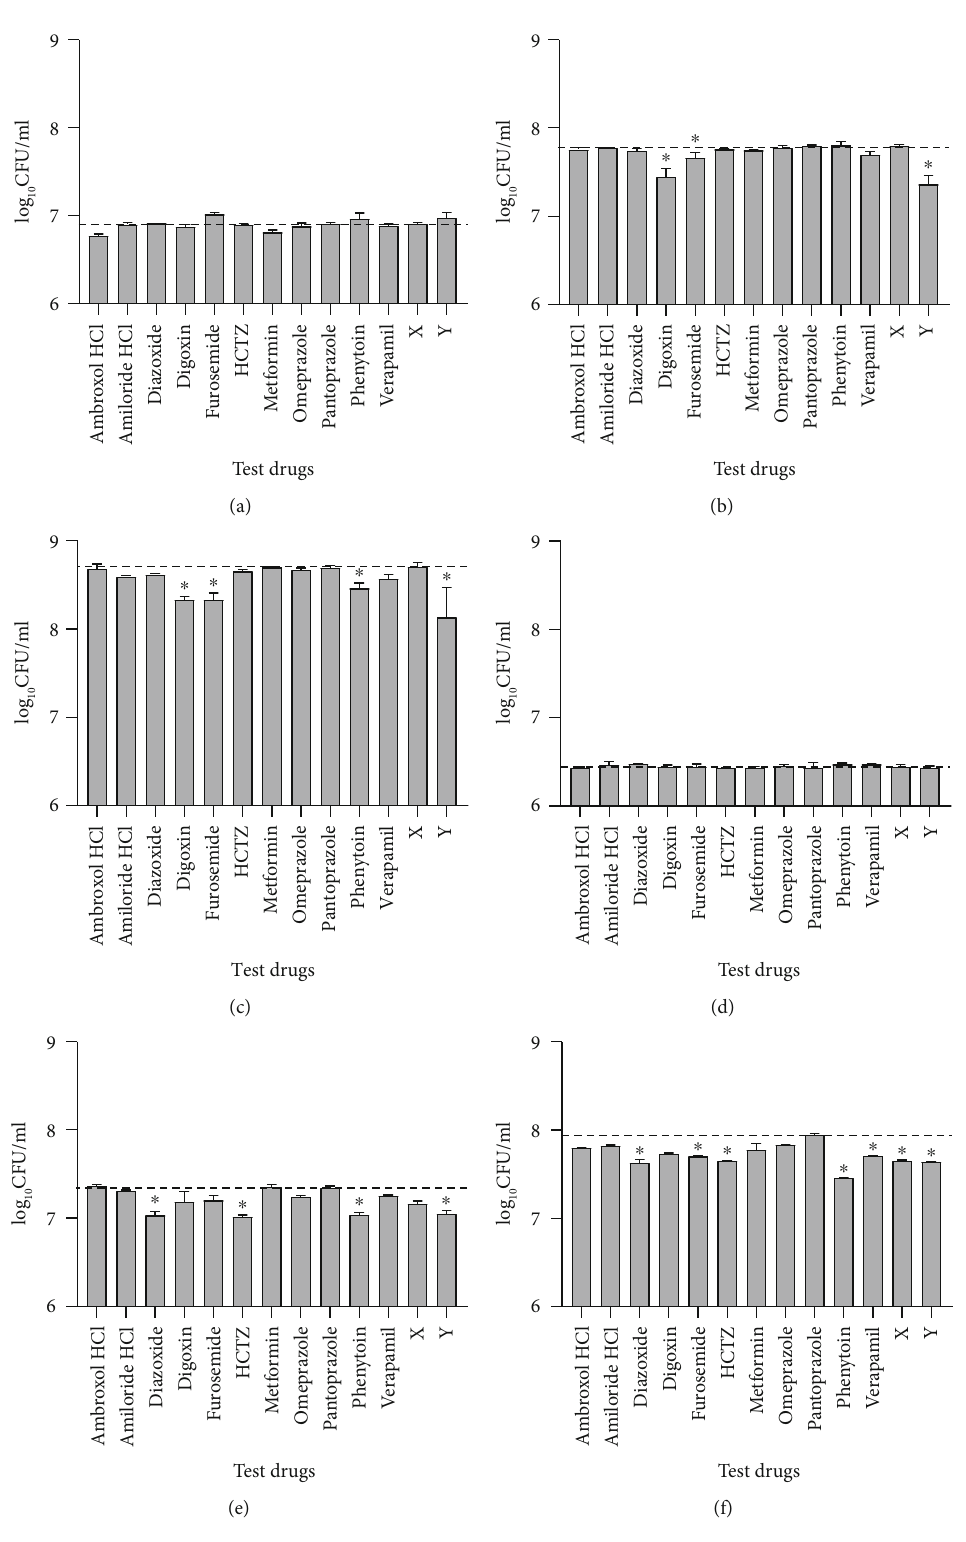
Figure 1: Median (+IQR) bacterial concentration (colony forming units/ml) after exposure of extracellular (a – c) and intracellular (d – f) M. bovis BCG to di ff erent test drugs for 3 (a, d), 6 (b, e), or 9 (c, f) days. Dashed lines indicate the CFU in drug-free controls. ∗ indicates p < 0 : 05 vs. drug-free controls. HCTZ: